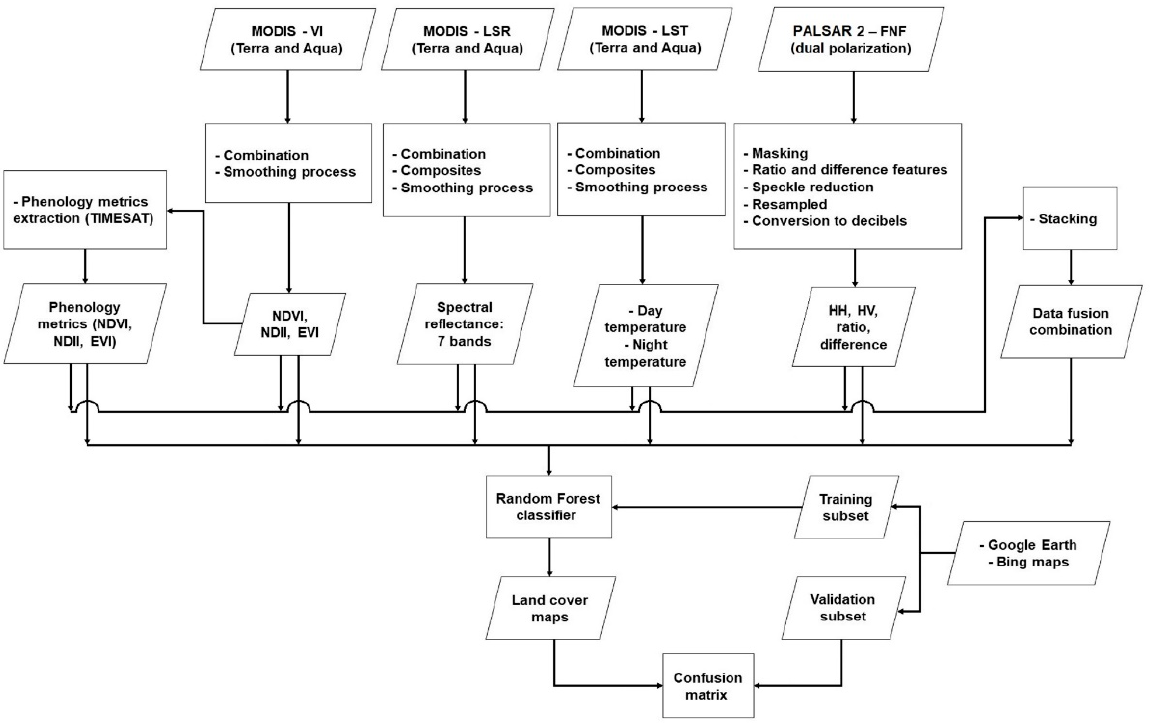
Figure 2. Image preprocessing workflow and classification scheme with the entire dataset. Please note that “combination” refers to the use of both image sources (Terra and Aqua satellites), while “composite” refers to the combination of images from different dates.